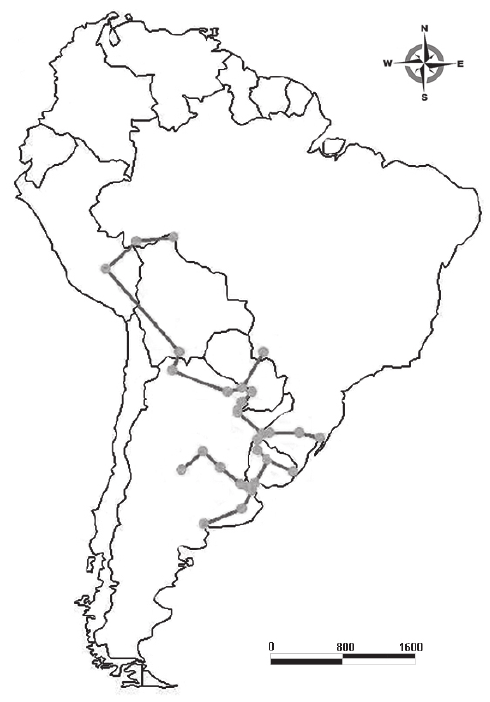
Fig. 7 - Individual track of Hemiauchenia paradoxa